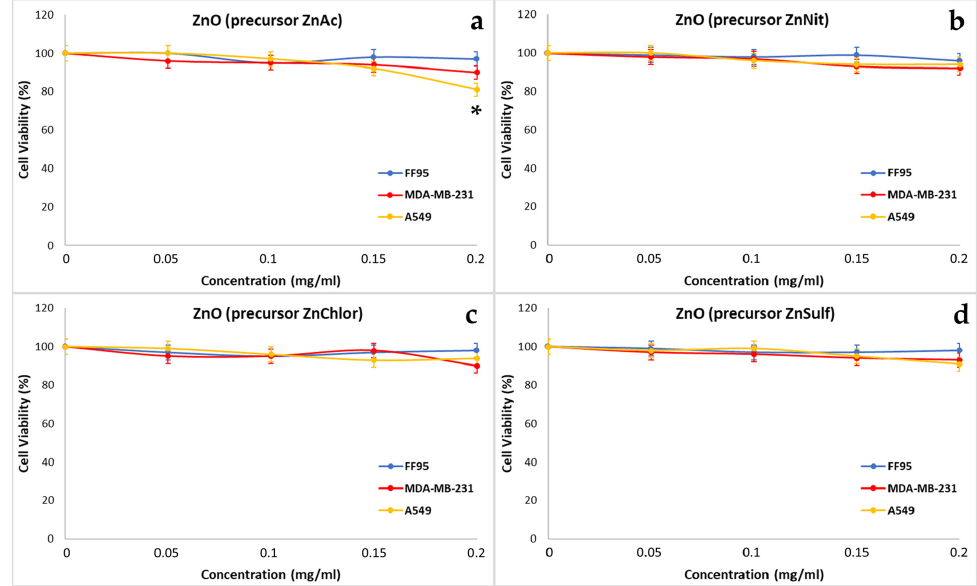
Figure 22. Effect of ZnO nanoparticles, synthesized using as precursor: ( a ) zinc acetate dehydrate (ZnAc), ( b ) zinc nitrate hexahydrate (in purple) (ZnNit), ( c ) zinc chloride (ZnChlor), and ( d ) zinc sulphate heptahydrate (ZnSulf) on FF95, MDA-MB-231, and A549 cells. There is not any significant decrease in cell population of any of the three cell lines because of the addition of ZnNit, ZnChlor, and ZnSulf, while ZnAc decreased the cell viability of A549 cells by ~20% at a concentration of 0.2 mg/mL. * p < 0.05 was considered as statistically significant. To evaluate the effect of the photo-activated ZnO NPs two series of experiments were realized. In our first approach, the cells were irradiated with visible light for 40 min, in